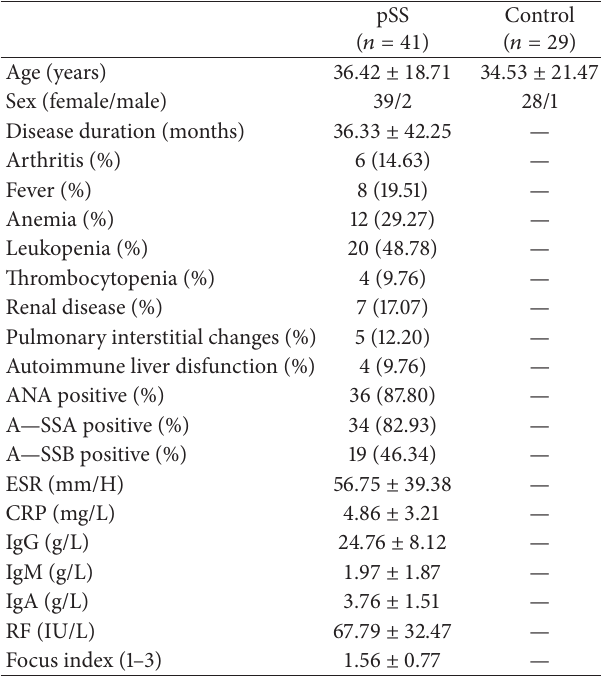
Table 1: Characteristics of pSS patients and the control